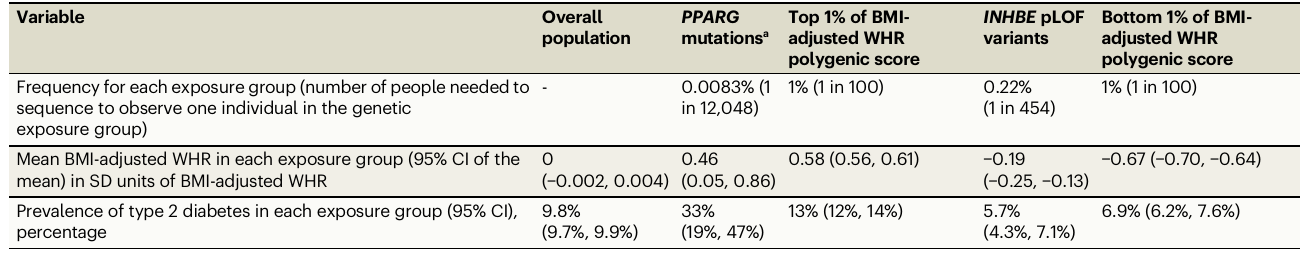
Table 2 | Fat distribution and prevalence of type 2 diabetes in high-impact genetic exposure groups Variable